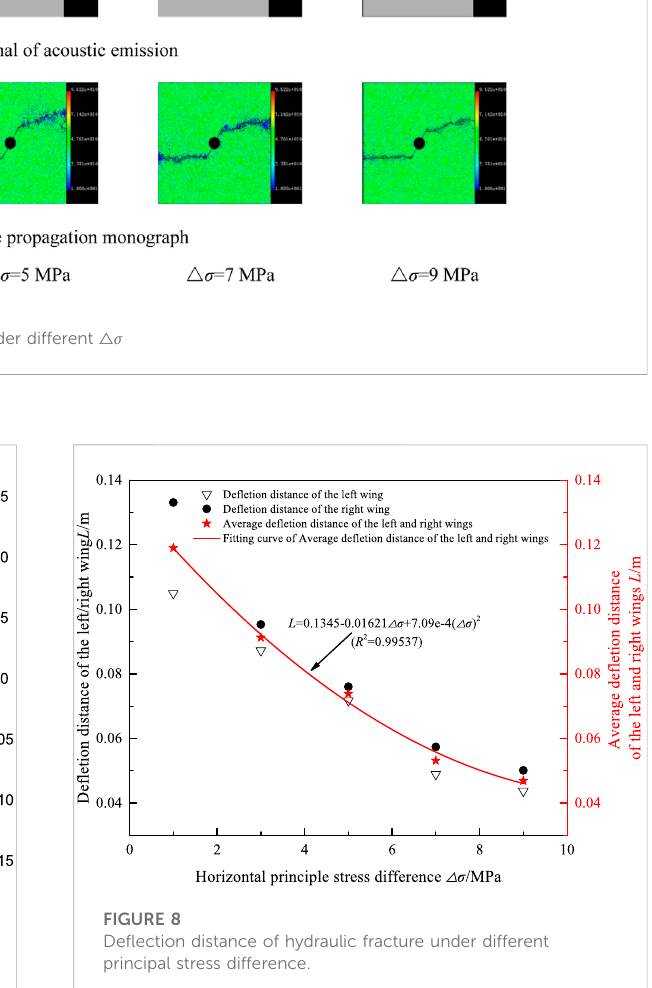
FIGURE 8 De fl ection distance of hydraulic fracture under different principal stress